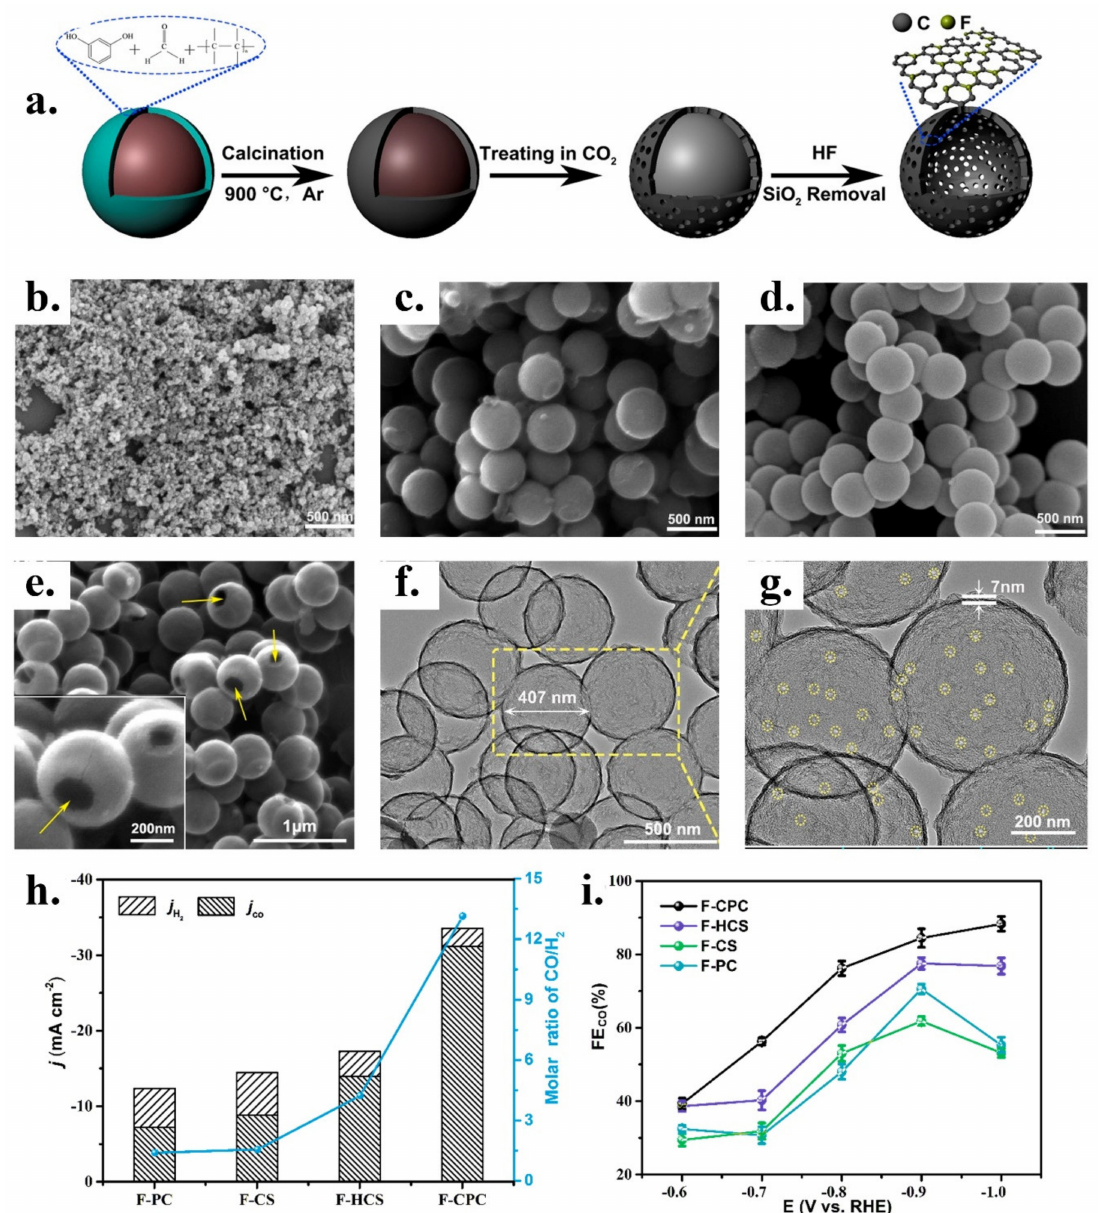
Figure 13. ( a ) Scheme of the synthesis of F-doped cage-like porous carbon (F-CPC), SEM images of F-doped ( b ) black pearls: F-PC, ( c ) carbon spheres: F-CS, ( d ) hollow carbon spheres: F-HCS and ( e ) cage-like porous carbon: F-CPC. ( f - g ) TEM images of F-CPC. ( h ) Geometrical current densities and the corresponding proportions of CO and H 2 at − 1.0 V vs. RHE on F-doped carbon catalysts and ( i ) FE for CO production at different applied potentials. Adapted from